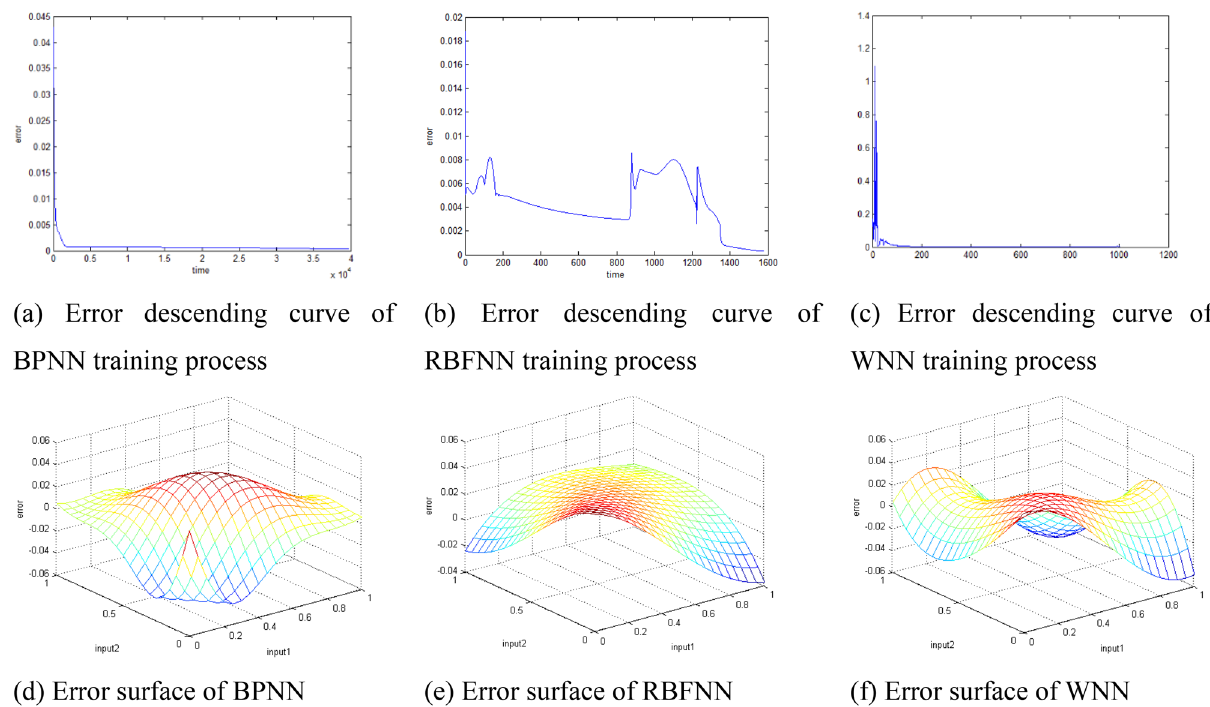
Figure 1. Error descending curve (time–error curve shows the descent process of error in 1CSP) was plotted in 2D figures. Error surface (all possible errors between 21 × 21 calculated outputs and target outputs) was plotted as 3D figures.